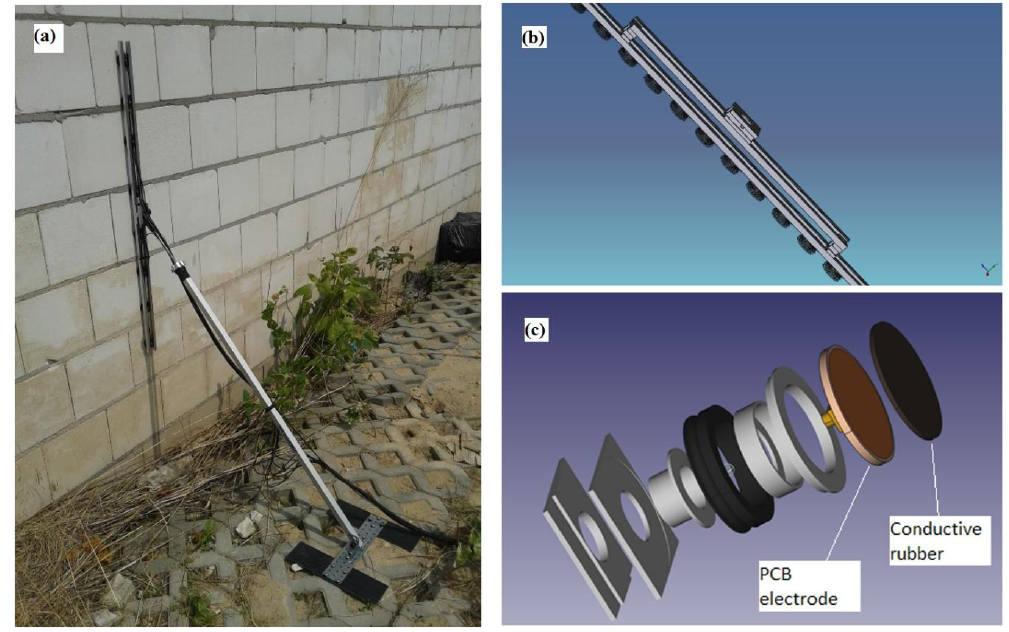
Figure 7. The concept of the electrodes. ( a ) way of fixing rubber electrodes to the building wall, ( b ) set of rubber electrodes, ( c ) structure of a single rubber electrode.